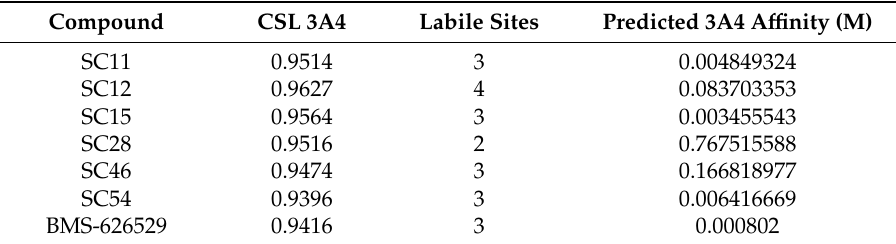
Table 1. Composite site lability (CSL) scores, number of labile sites, and predicted CYP3A4 a ffi nities of compounds used in this study. CSL values and the number of labile sites were determined